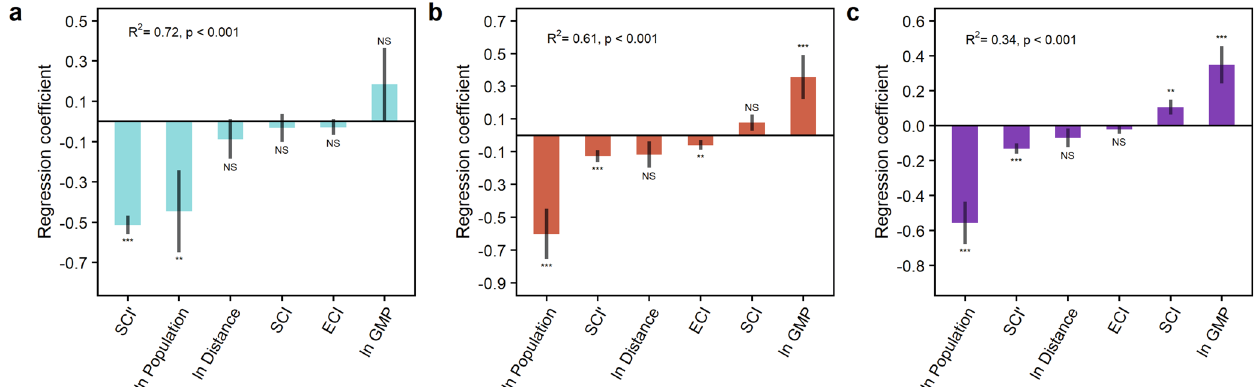
Fig. 3 Effect of supply chain complexity on the intensity of supply chain shock. Coef fi cients associated with the regression of the supply chain shock intensity on the supply chain complexity indices and several control variables [ln population, ln average distance, standardized economic complexity index (ECI), and ln gross metropolitan product (GMP)]. The shock intensities are calculated using data for 2012-2015 and the explanatory variables using data for 2012. a Coef fi cients obtained using the average shock intensity of a city ’ s main imports as the response variable ( n = 69). b Coef fi cients obtained using the average shock intensity of all imports to a city as the response variable ( n = 69). ( c ) Coef fi cients obtained using the shock intensity of individual city-product pairs as the response variable ( n = 2512). The standardized regression coef fi cients are shown in Fig. S6. ***, P < 1%; **, P < 5%; and NS (nonsigni fi cant), P > 10%. The standard error is indicated with the black vertical line. These regression analyses are for the city data